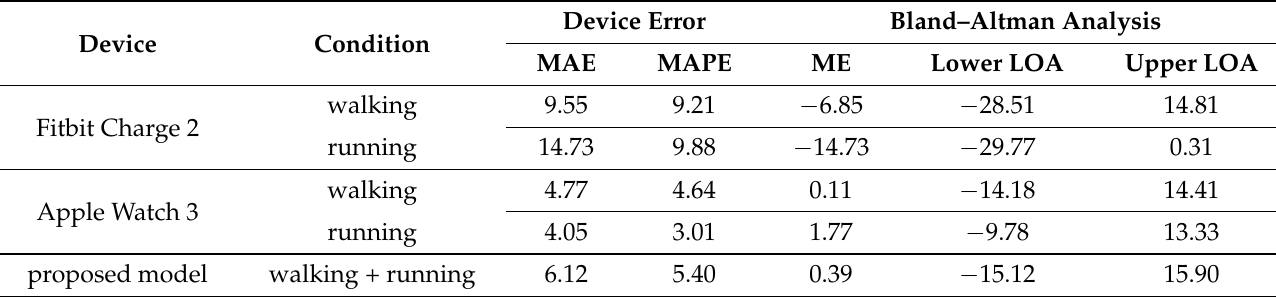
Table 6. Comparison of the HR estimation performance of commercial wearable devices and the proposed model. The performance of commercial wearable devices was cited from the study results of Nelson et al.